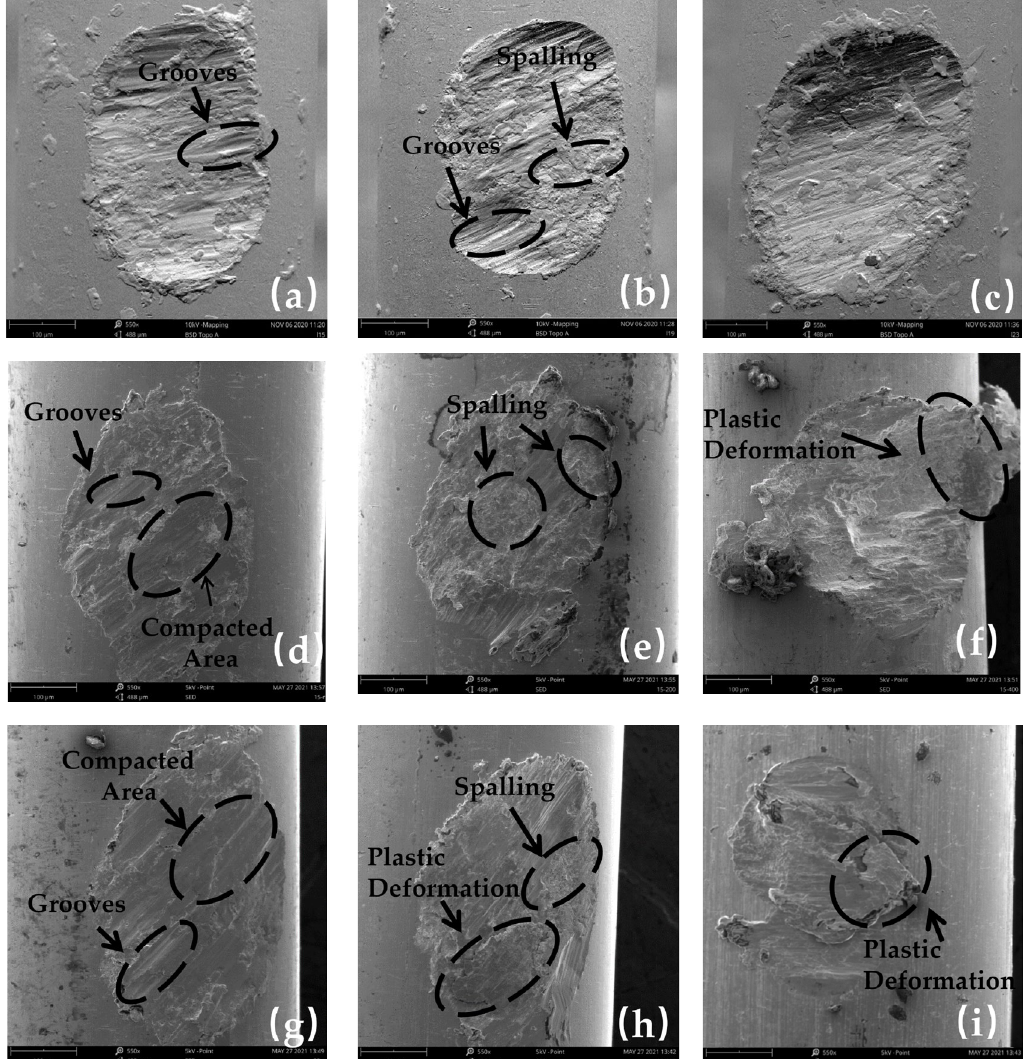
Figure 6. SEM images of worn surface under different loads and temperatures: ( a ) 20 °C—10 N; ( b ) 200 °C—10 N; ( c ) 400 °C—10 N; ( d ) 20 °C—15 N; ( e ) 200 °C—15 N; ( f ) 400 °C—15 N; ( g ) 20 °C—20 b ) 200 ◦ C—10 N; ( c ) 400 ◦ C—10 N; ( d ) 20 ◦ C—15 N; ( e ) 200 ◦ C—15 N; ( f ) 400 ◦ C—15 N; N; ( h ) 200 °C—20 N;( i ) 400 °C—20 N. ( ( g ) 20 ◦ C—20 N; ( h ) 200 ◦ C—20 N; ( i ) 400 ◦ C—20